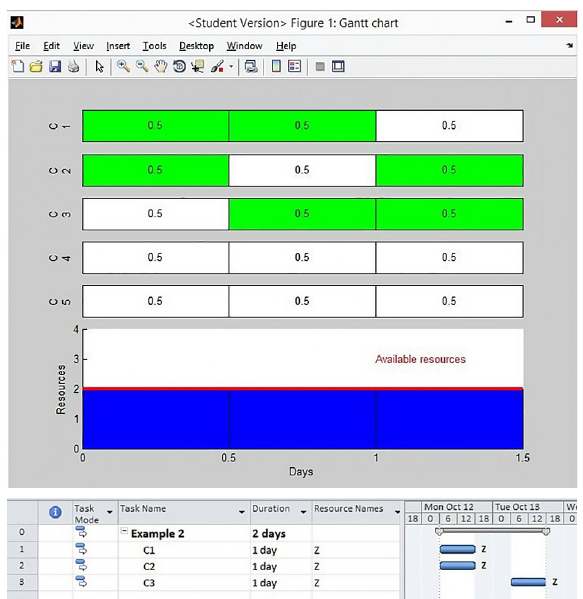
Fig. 6. A solution for Network 2 using FROPT and